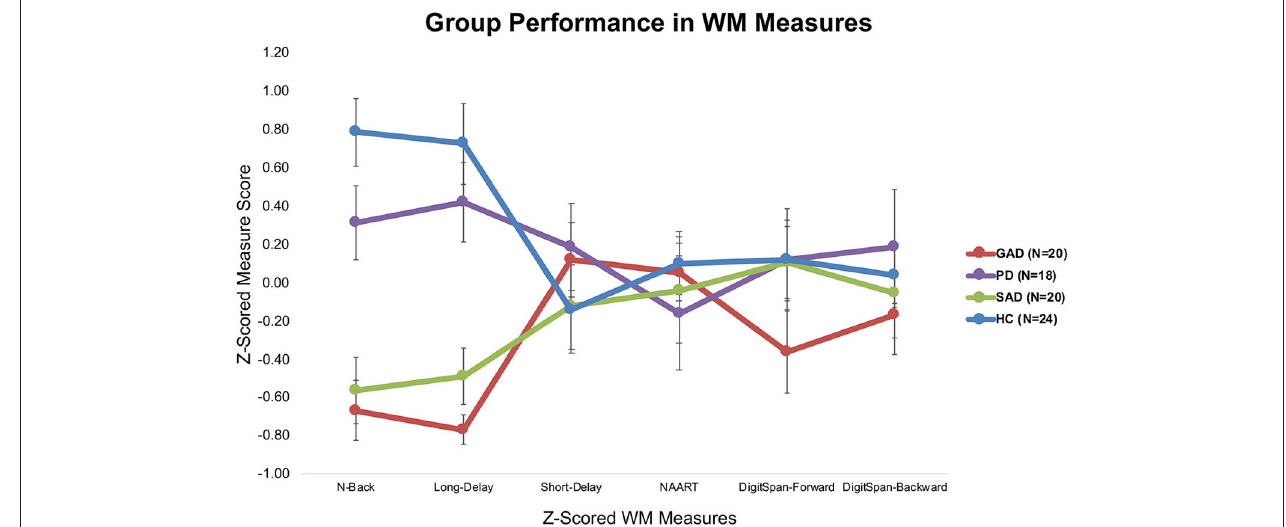
FIGURE 1 | Average z-scored performance of different groups on WM measures ( ± SEM).